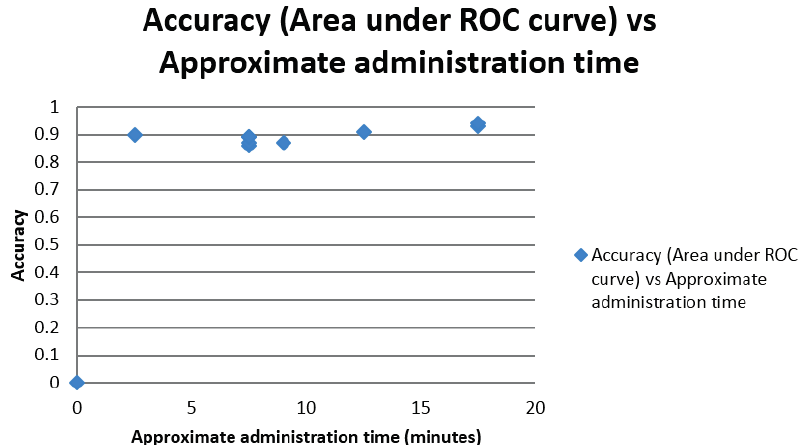
Figure 6. Scatter plot of area under ROC curve versus approximate test administration